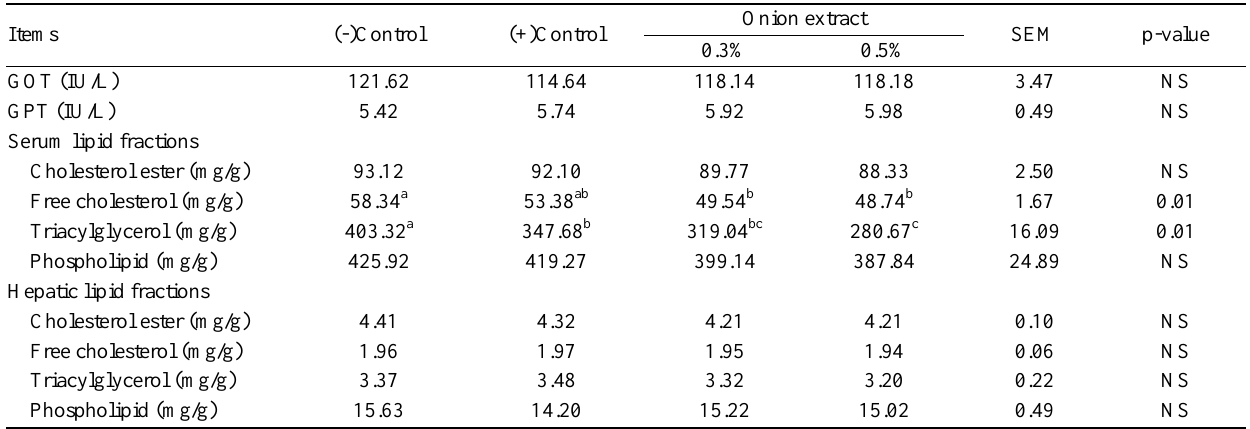
Table 4. Dietary effects of onion extract on the enzyme activities and lipid fractions of serum and liver of White mini broilers 1